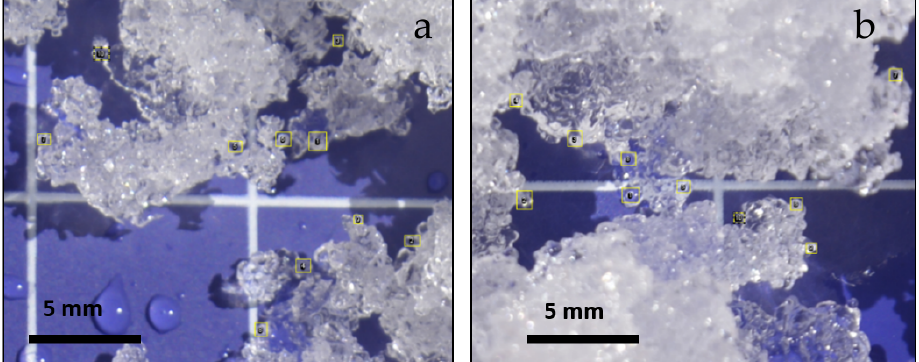
Table 1. Parameters for snow contamination characterisation (previously contaminated refers to “clean” snow). Figure 6. Example of snow particles size analysis for the 16 December 2021 ( a ) and the 8 April 2022 ( b ). Ice particles are surrounded by yellow rectangles since particles are not completely spherical. Particle diameters were calculated as the mean height and width of the rectangles.